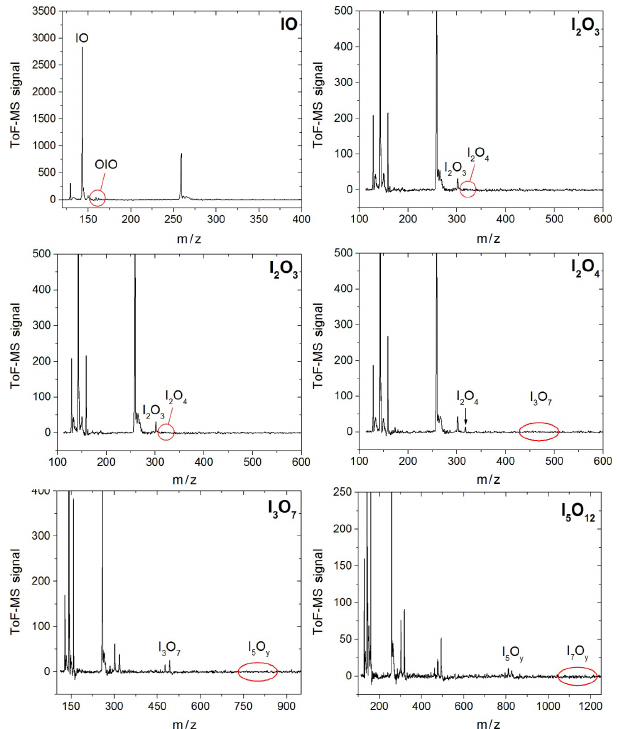
Figure B1. Mass spectra corresponding to the optimized time de- lays shown in Fig. 5. The plots are generated by averaging the signal obtained for each mass over the 5ms window. The species of inter- est is given in the top right corner of each